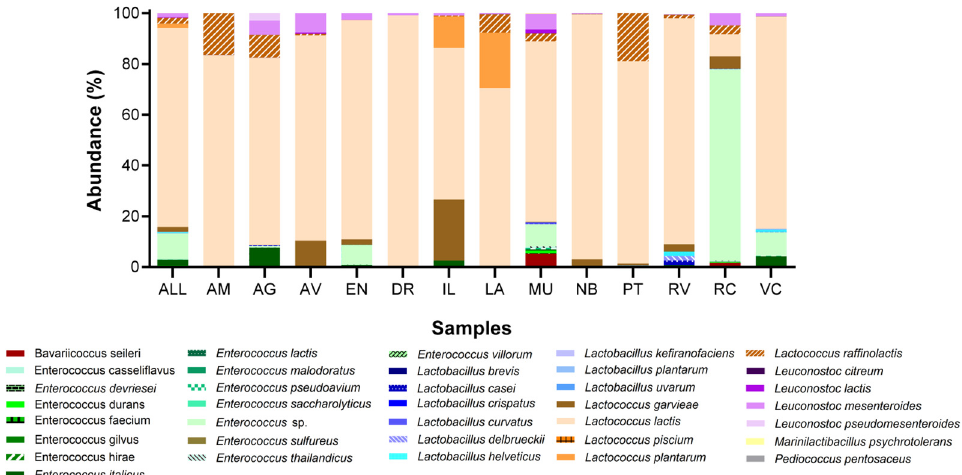
Figure 3. Abundance and distribution of species in seven-day aged artisanal cheese samples. (All) represents the sum of all samples.